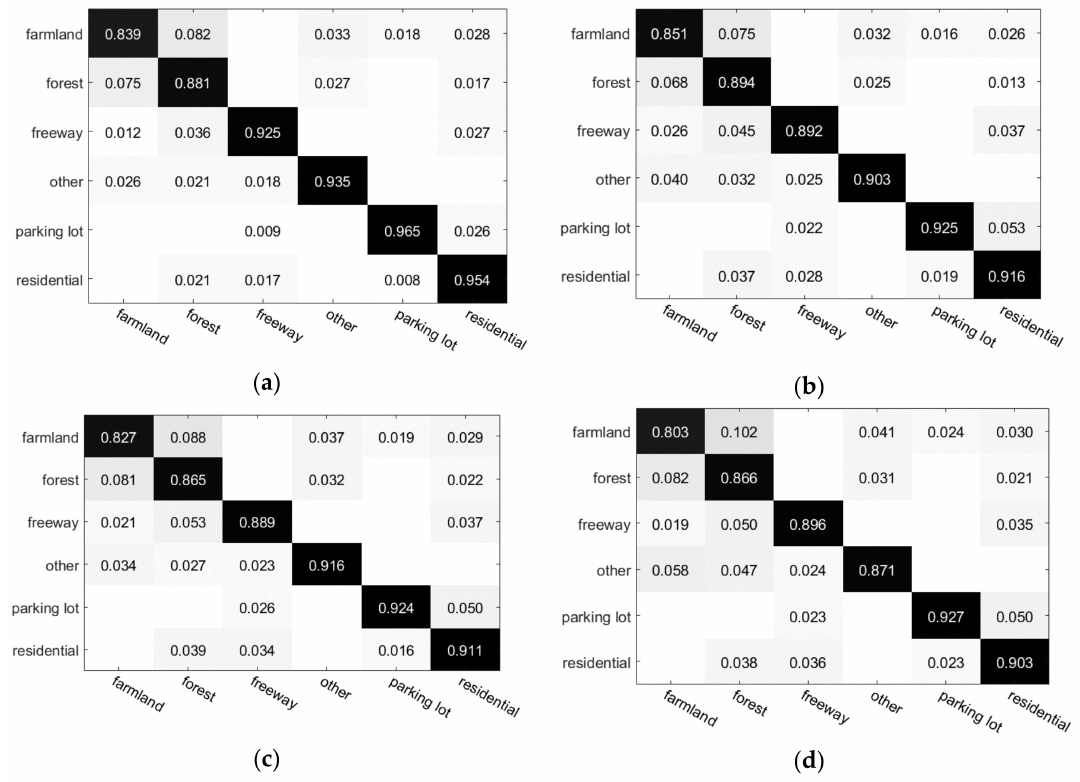
Figure 16. Confusion matrix showing the classification performance with the SIRI-WHU dataset: ( a ) color-boosted saliency-guided rotation invariant BOVW representation with parameter transfer; ( b ) only without the CBGCSRD method; ( c ) only without rotation invariant BOVW representation; and ( d ) only without transferring SVM parameters from the source to the target